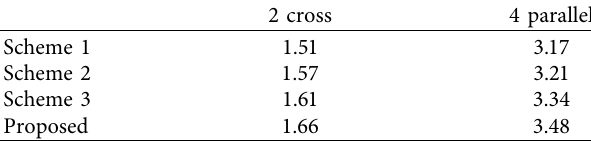
Table 1: Transmission rates of different data streams (10 2 kbps).